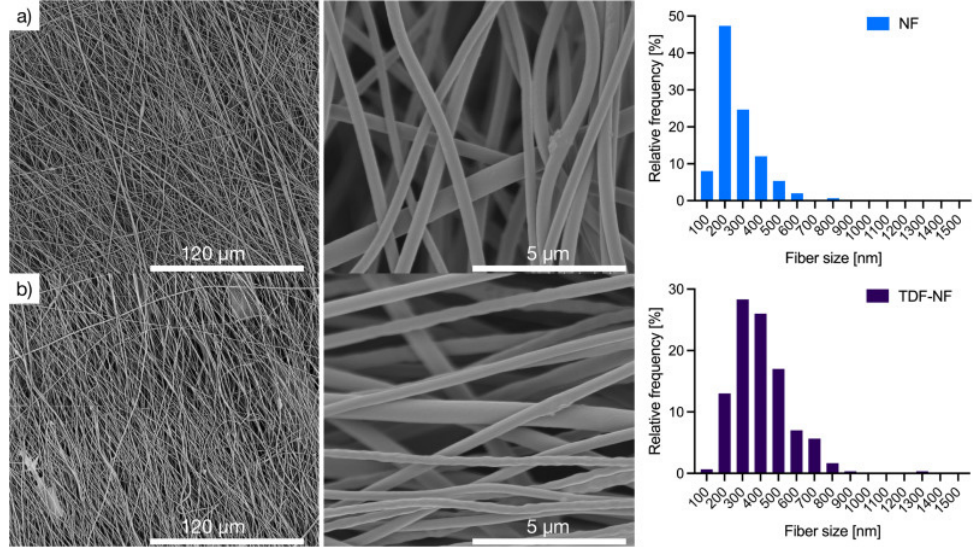
Figure 15. Representative SEM (scanning electron microscope) images and fiber size distributions ( n = 300) of ( a ) drug-free nanofibrous mat (NF) and ( b ) tenofovir disoproxil fumarate-loaded nanofibrous mat (TDF-NF) prepared with CS and PEO at a ratio of 1:4 ( w / w ). SEM images magnifications: ×1000 and ×10,000 [258]. Reproduced with permission from Elsevier (Copyright©2022).